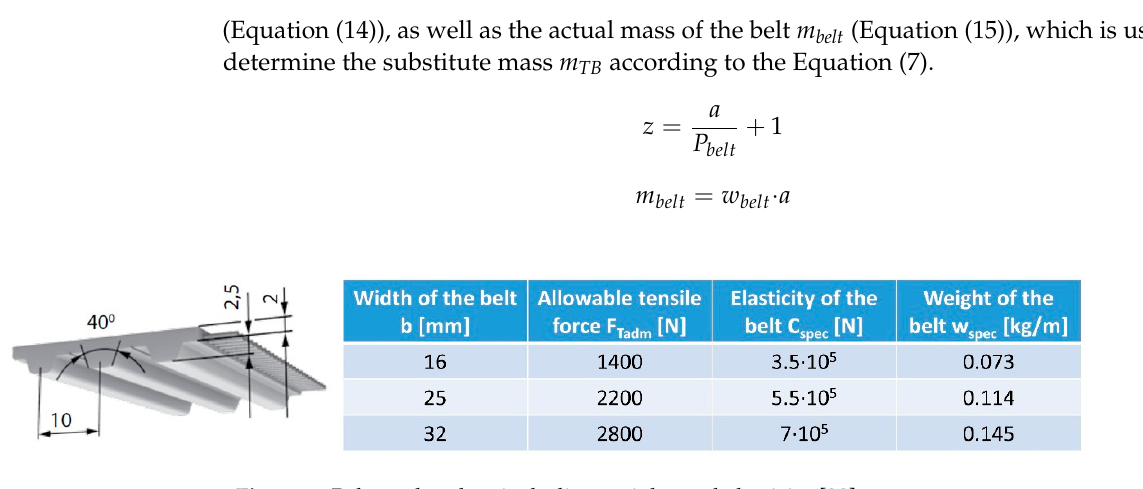
Figure 6. Belt catalog data including weight, and elasticity [28].